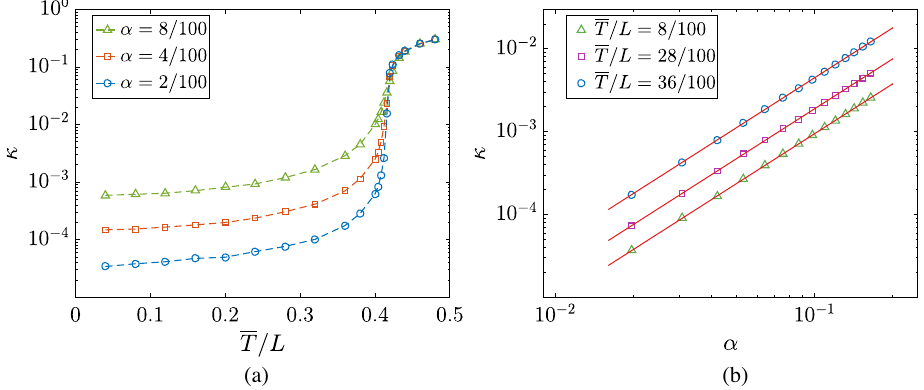
¯ T=L FIG. 11. (a) The slope κ of entanglement entropy growth as a function of , for different magnitudes of randomness α . Note that the phase transition from nonheating to heating phases with no randomness ( α ¼ 0 ) happens at T (cid:4) =L ≃ 0 . 416 . (b) The slope κ of ¯ T entanglement entropy growth as a function of α , for different . The red solid lines are fittings with κ ∝ α 2 . Each κ is extracted from the 1000 . n Þ by averaging over N CFT calculation of S A ð sample ¼